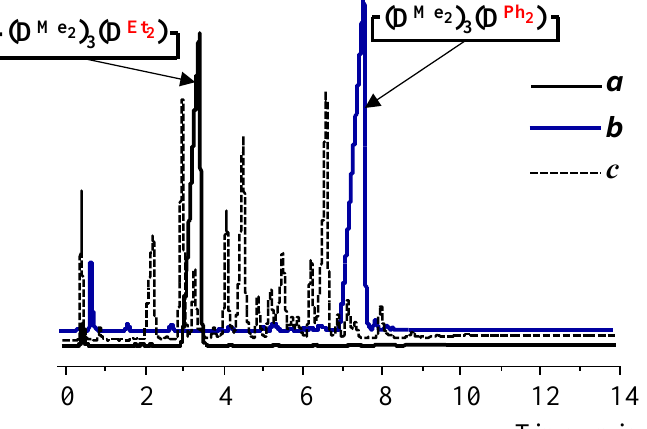
Figure 2. GLC curves of volatile products 4 (a) (Table 1), 12 (b) (Table 2), obtained at the reaction temperature of − 60 °C, and the product of the interaction of the salt with dichlorodiethylsilane at room temperature.